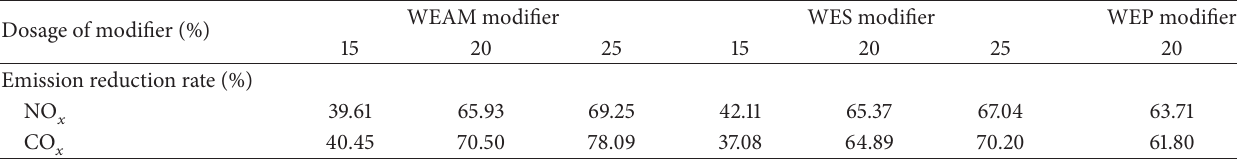
Table 3: Emission reduction rates of different types of modified asphalt.